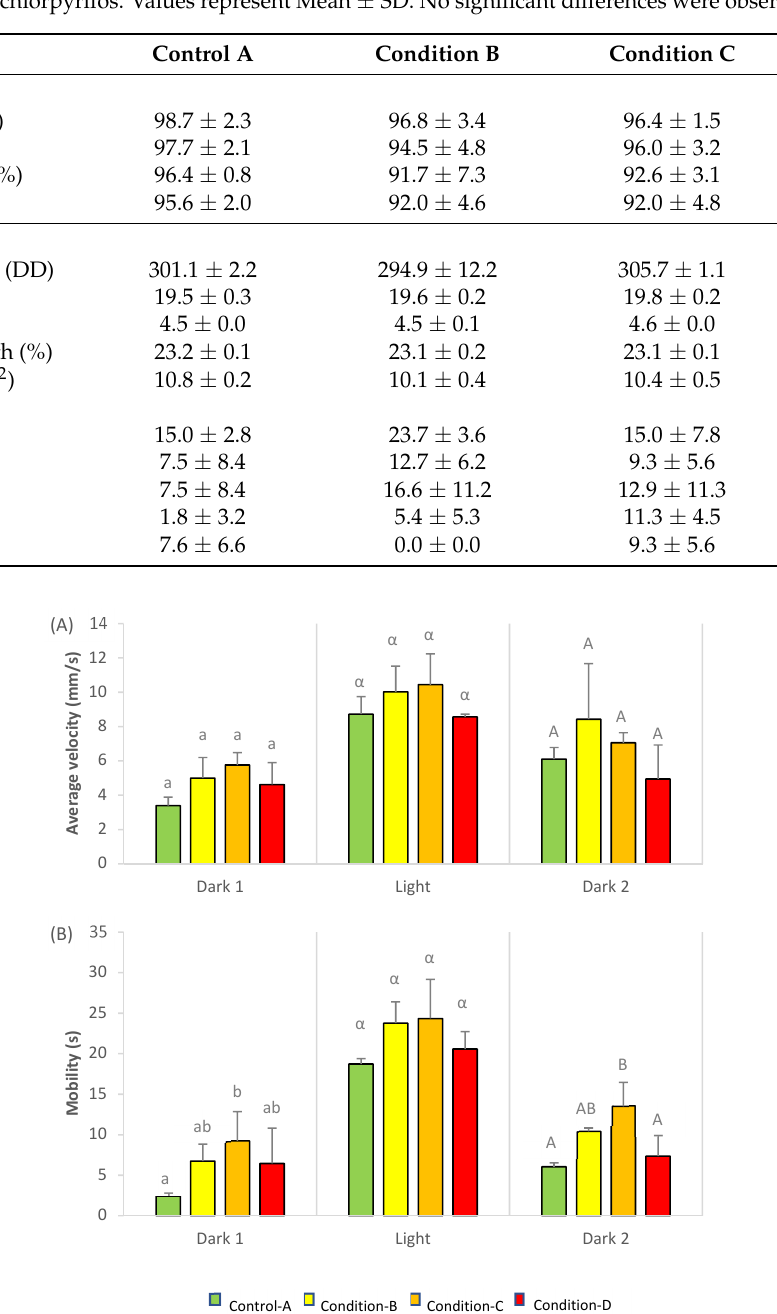
Figure 1. Velocity average (mm/s) ( A ) and cumulative time of mobility (s) ( B ) of rainbow trout larvae following exposure to a mixture of three pesticides, copper, glyphosate and chlorpyrifos. Different letters at the top of the bars indicate significant differences between conditions. Values represent Mean ± SD ( n = 3, ANOVA, p < 0.05).